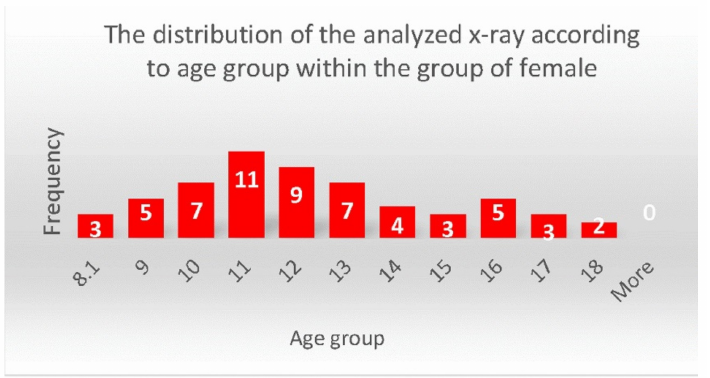
Figure 3. The distribution of the analyzed X-rays according to age groups within the group of